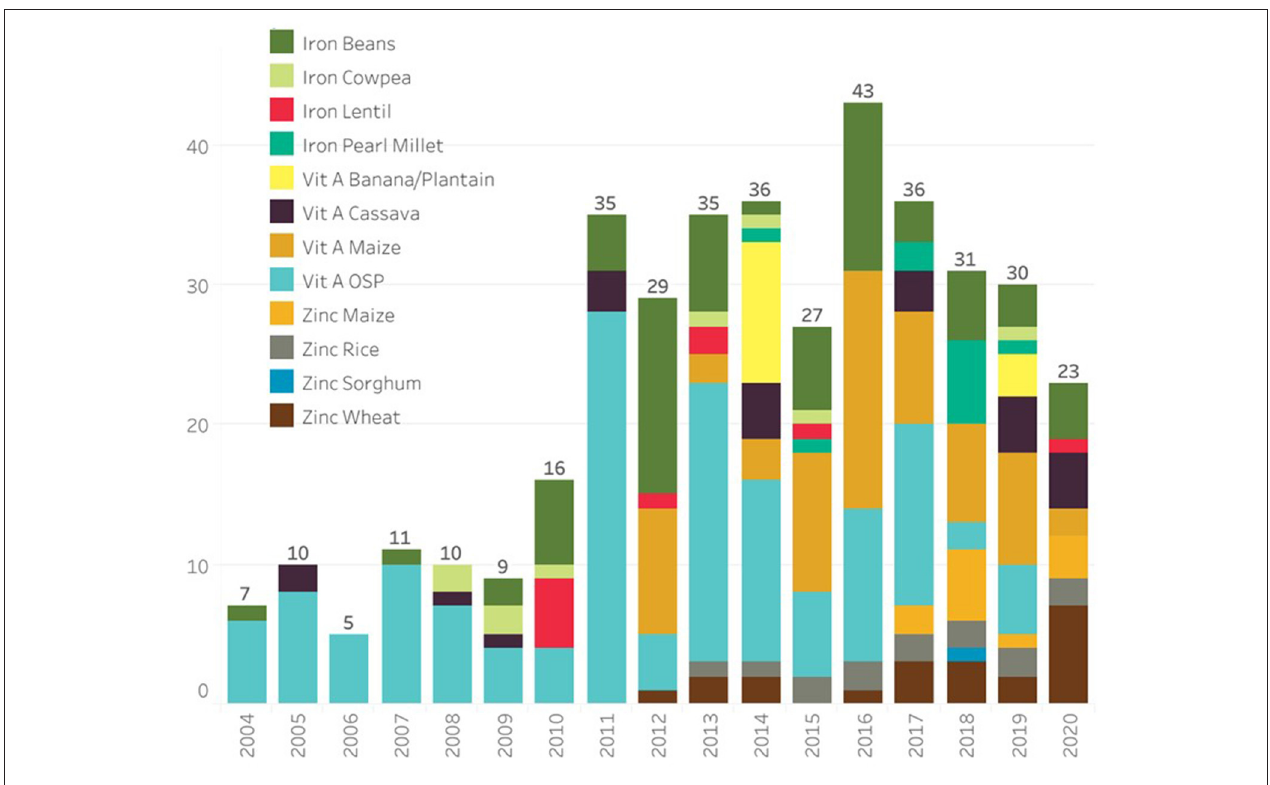
FIGURE 2 | Biofortified crop cultivars released from 2004 to 2020 (source: